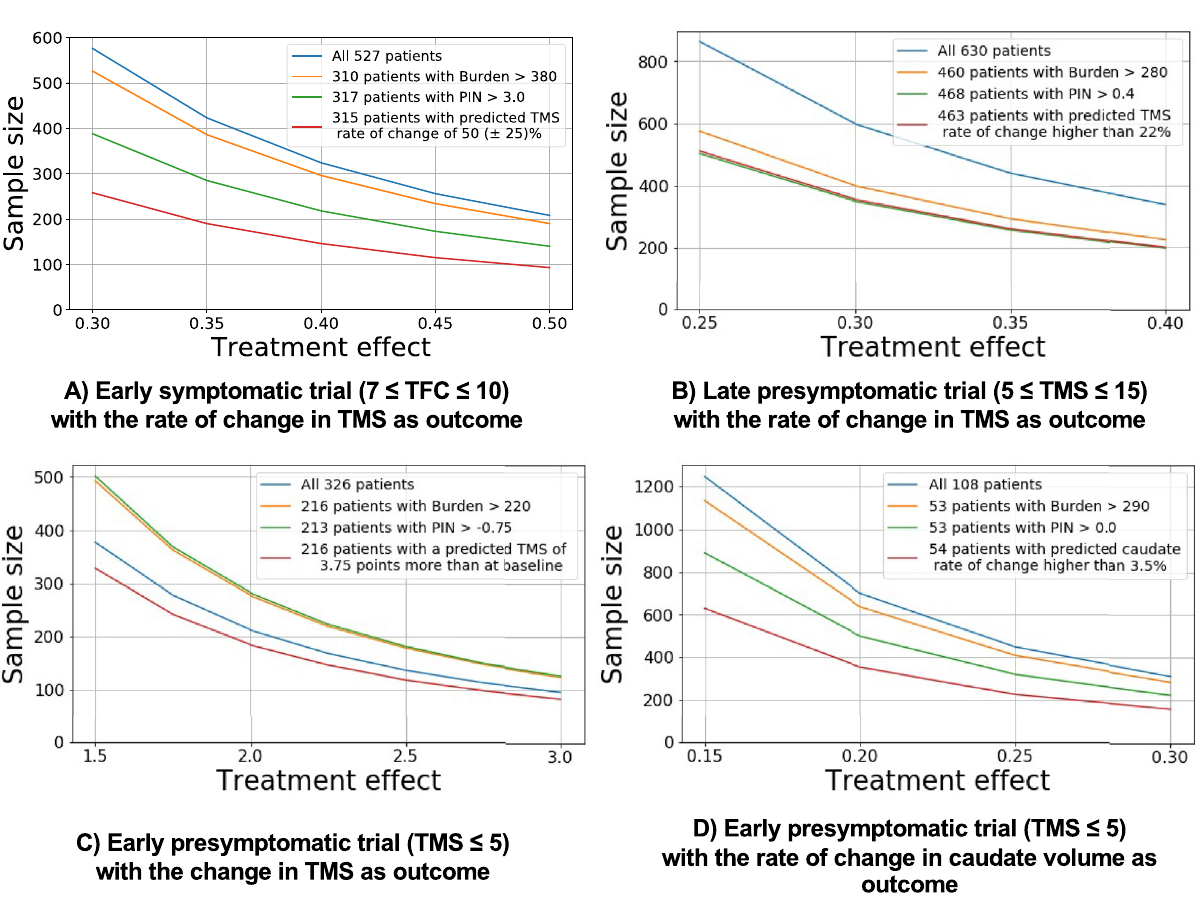
Figure 6. HD COURSE MAP reduces the number of necessary participants compared to PIN and CAP. Each panel represents a simulated trial on a particular disease stage with different outcome measures. Blue curves represent every participant meeting the prespecified inclusion criteria. Orange, green and red curves represent participants selected based on the burden score, the PIN score or HD COURSE MAP respectively. The experiments in panels ( A – C ) use ENROLL participants. Experiment in ( D ) use TRACK participants.